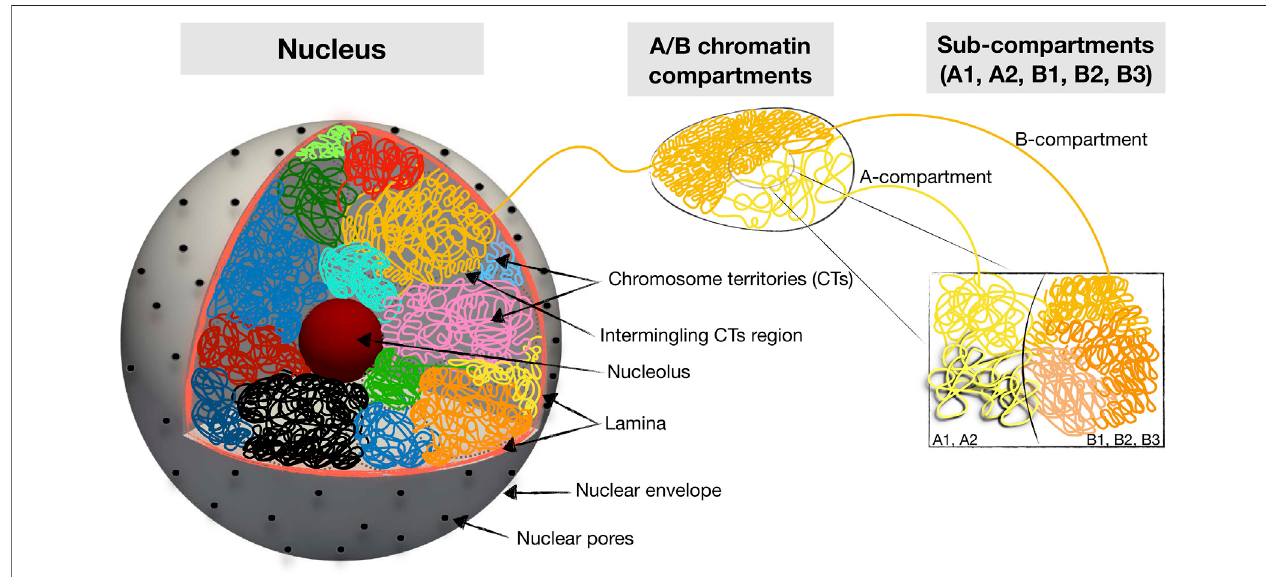
FIGURE 1 | Schematic summary of hierarchical 3D folding of chromatin into compartments and domains. Shown are various keywords relevant for describing nuclear chromatin architecture along with length scales relevant for modeling and imaging